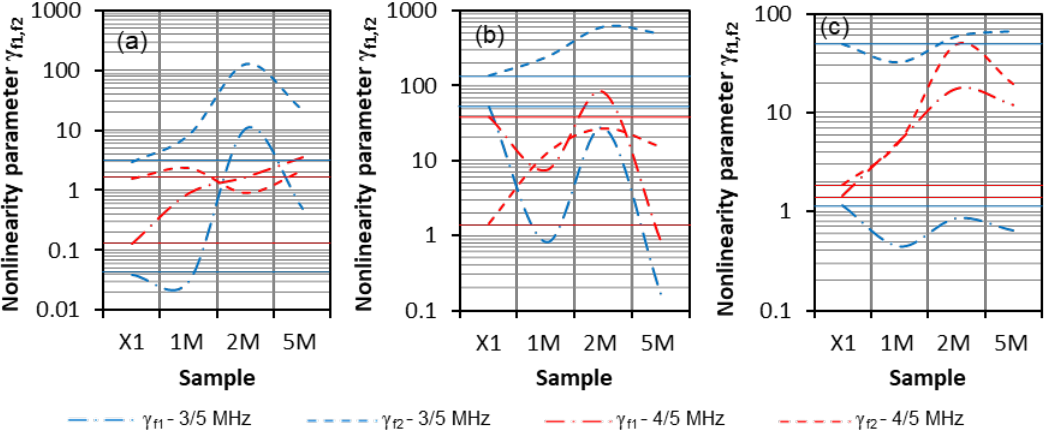
Figure 17. Comparison of 𝛾 𝑓1 and 𝛾 𝑓2 parameters: ( a ) α = 50°; ( b ) α = 60°; ( c ) α = 90°.